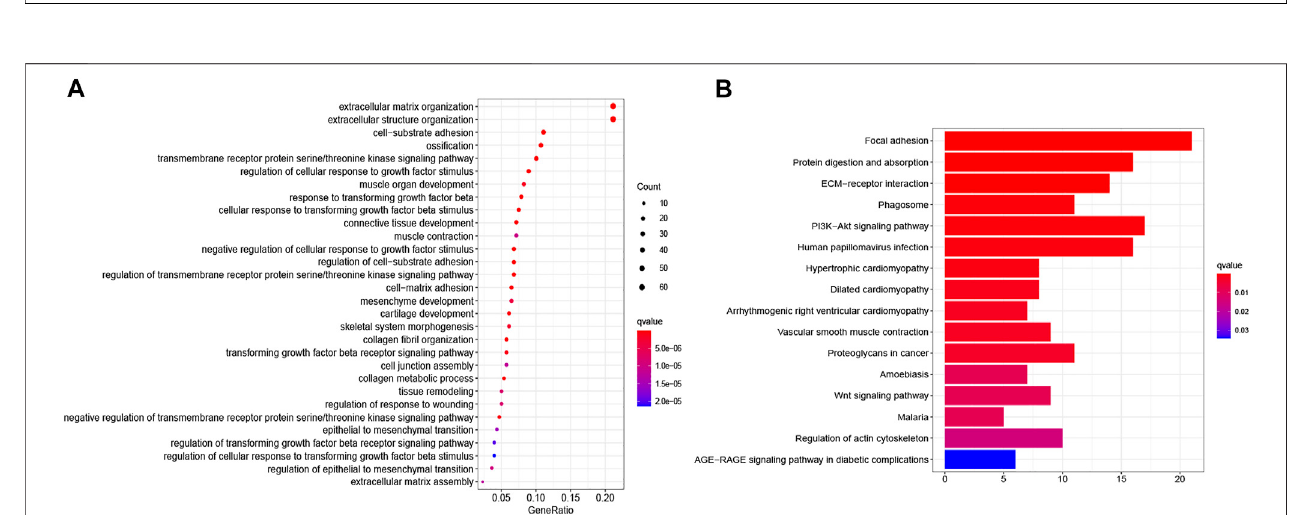
FIGURE 9 | The gene set enrichment analysis. (A) Bar plot of GO enrichment. (B) Bar plot of KEGG enriched terms.